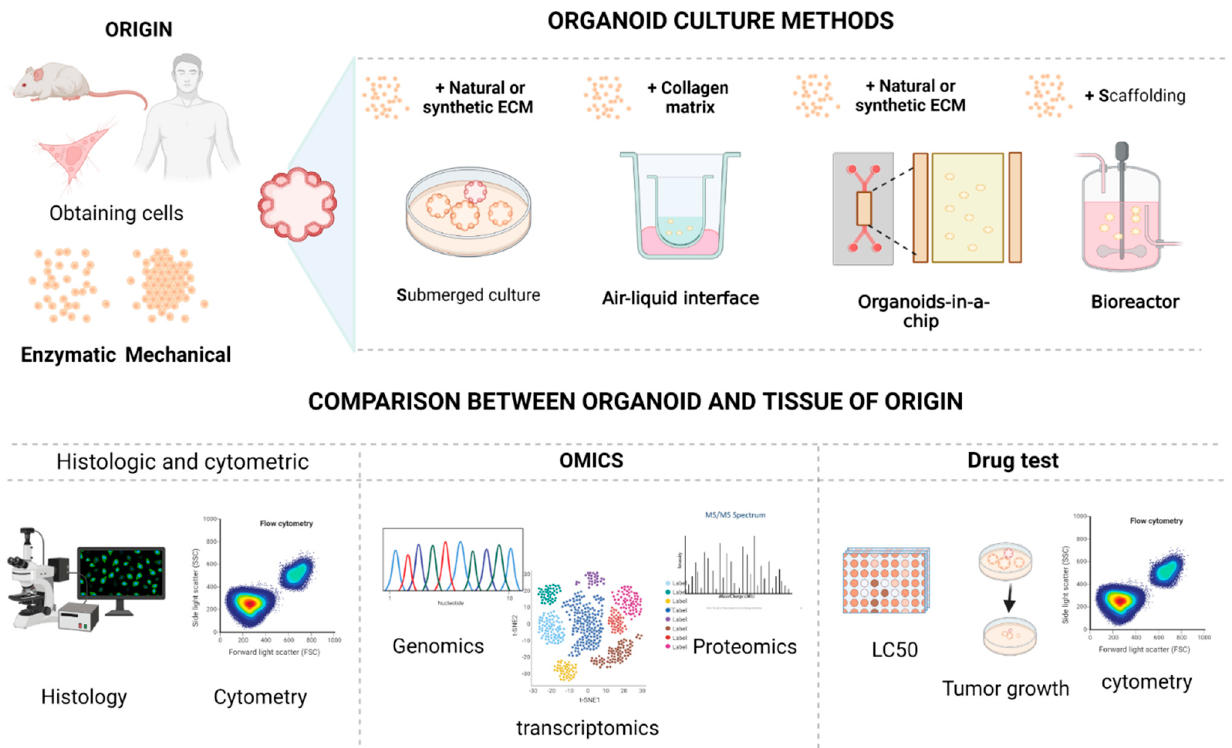
Figure 5. Process for obtaining and seeding tumor organoids and comparison techniques of organoids with their provenance system. Created with BioRender.com